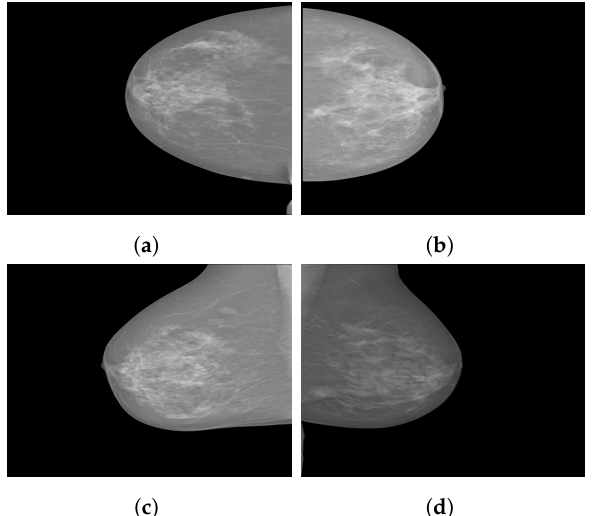
Figure 3. Sample images from the INbreast database. ( a ) Craniocaudal (CC) view of the right breast; ( b ) CC view of the left breast; ( c ) mediolateral oblique (MLO) view of the right breast; ( d ) MLO view of the left